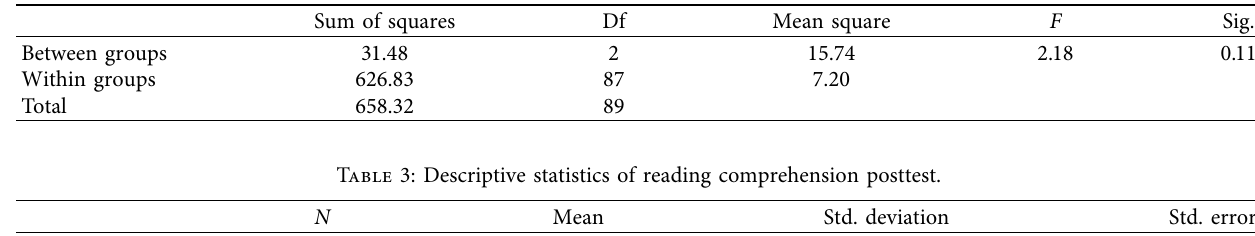
Table 2: Inferential statistics of reading comprehension pretest.